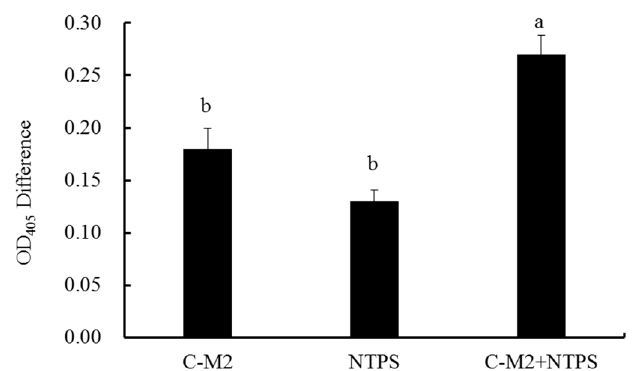
Figure 4. Cell membrane permeability of Morganella sp.wf-1 with different treatments. Different lowercase letters (a, b) indicate significant differences ( p < 0.05).